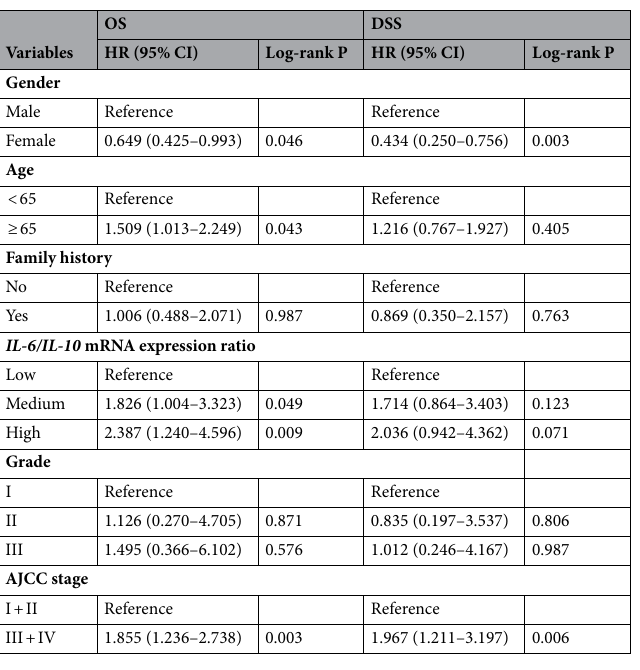
Table 3. Univariate Analysis for OS and DSS of STAD Patients without Distant Metastasis.